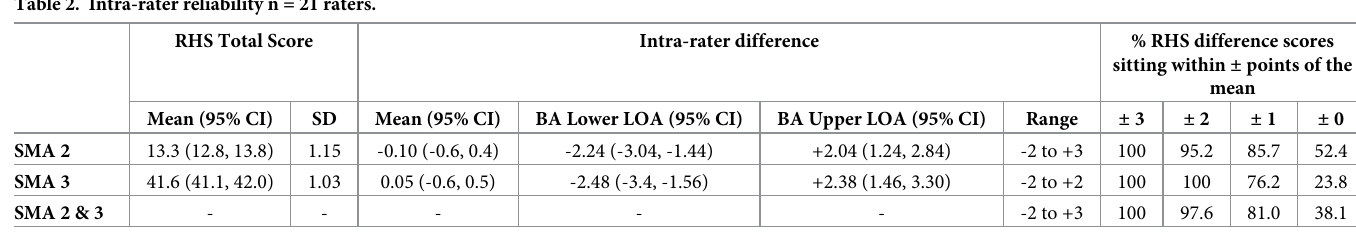
Table 2. Intra-rater reliability n = 21 raters.